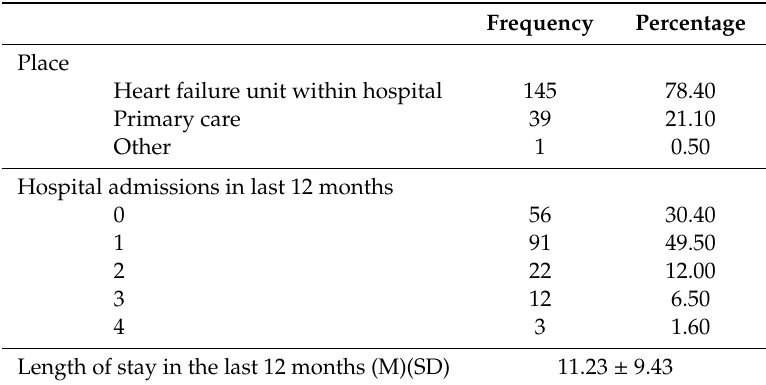
Table 1. Heart failure (HF)